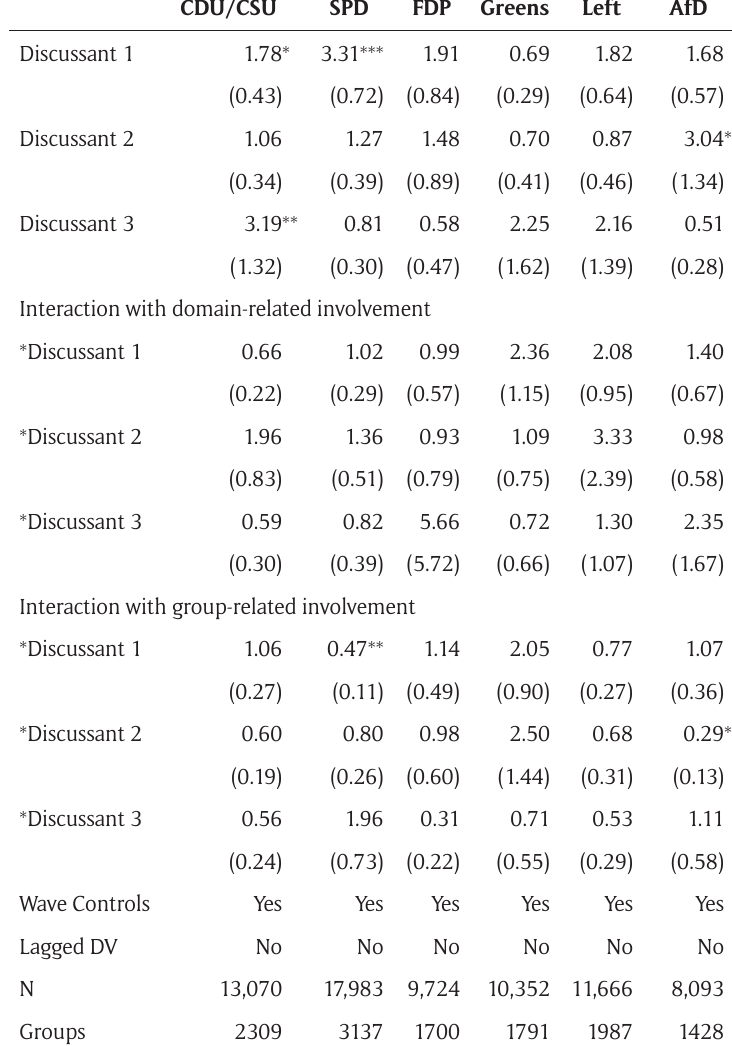
Table 2: The influence of changes in discussants’ vote intentions on changes in the respondent’s vote